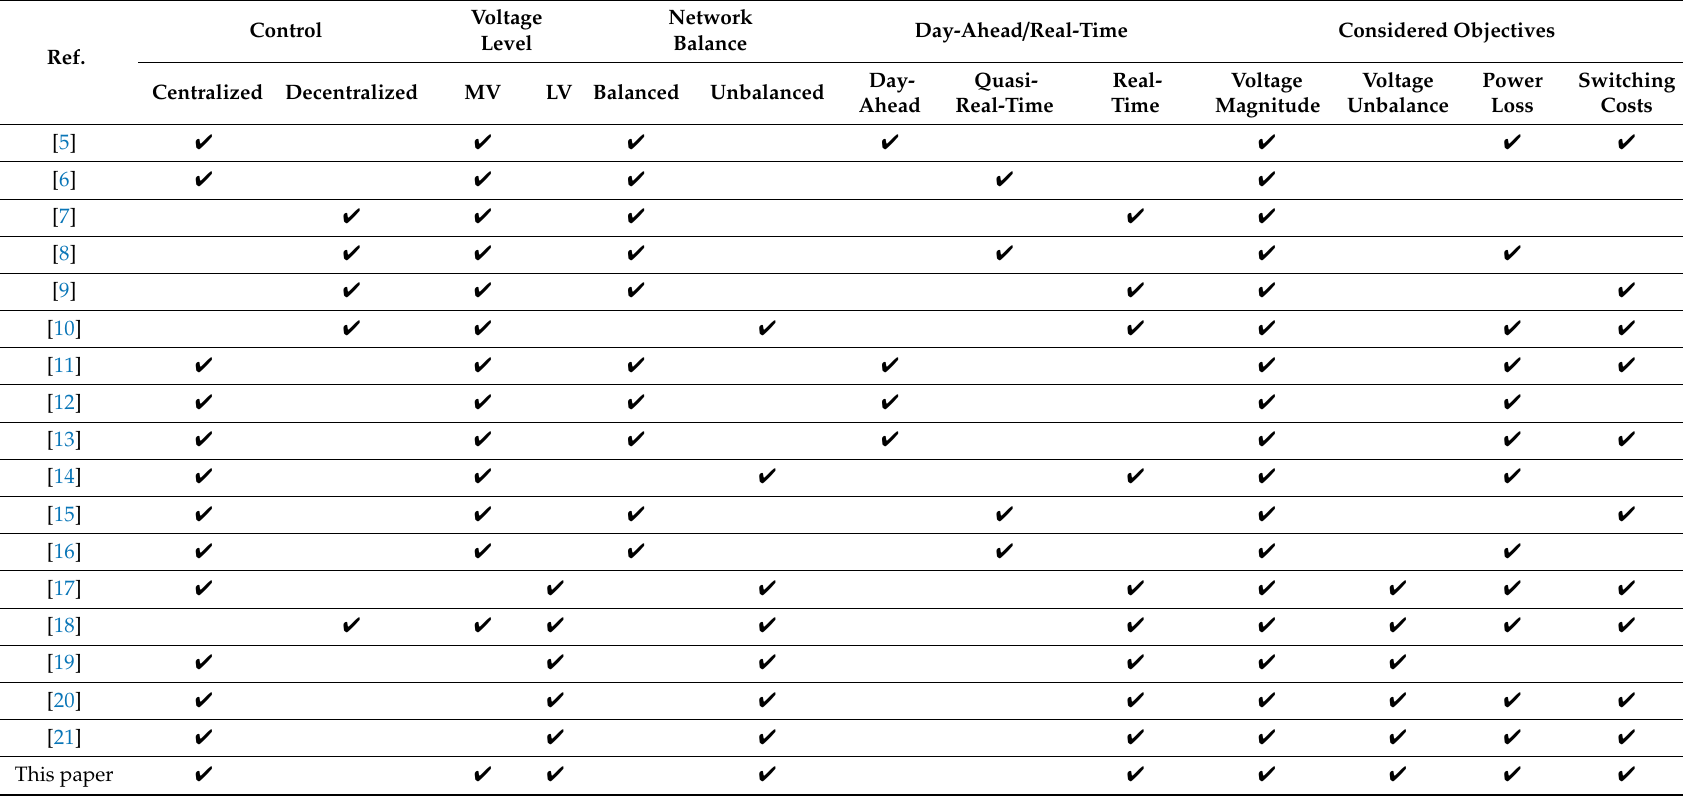
Table 1. Comparison of existing volt-var (VV) optimization and coordination approaches and the proposed technique in this paper.